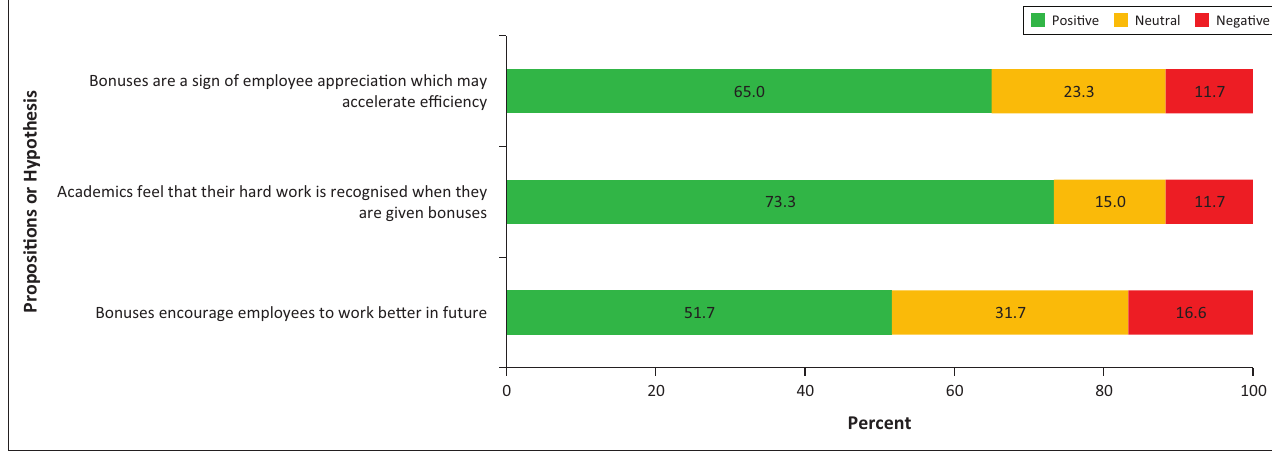
FIGURE 4: Bonuses for knowledge-sharing in higher education institutions ( n =